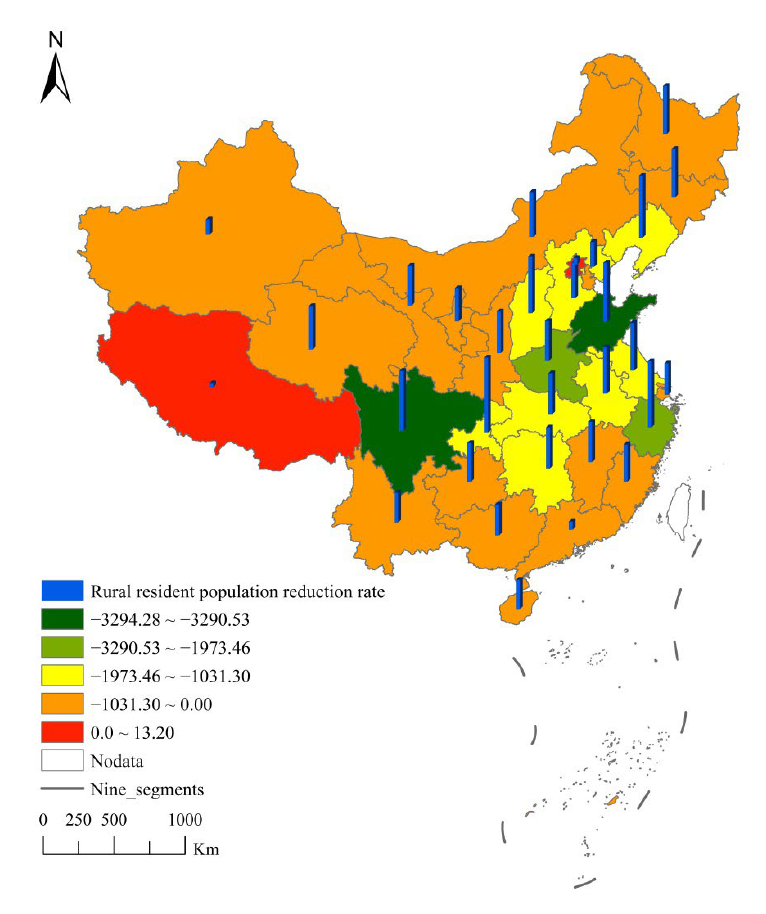
Figure 2. Spatial pattern of absolute increase and average annual decrease rate of rural permanent population from 2007 to 2020.